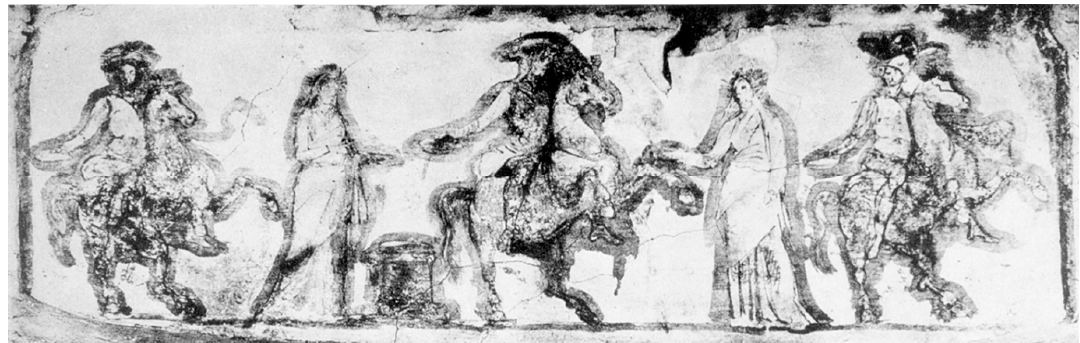
Figure 9. Moustapha Kamel Tomb I painted frieze. After (Venit 2002, p. 57, Figure 42).